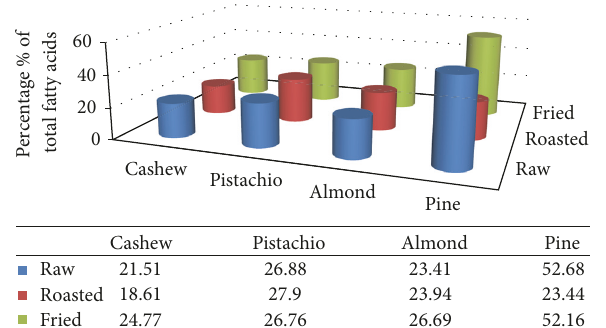
Figure 3: Linoleic acid%.